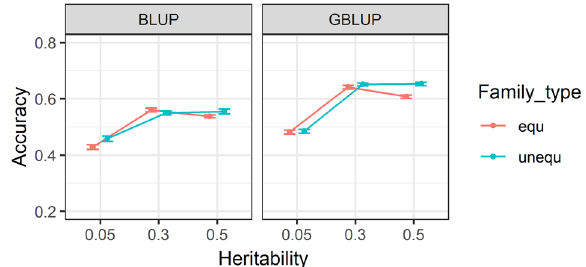
Figure 3. Accuracy of (genomic) estimated breeding values (G)EBV within three heritabilities. The accuracies are provided for equal and unequal family contributions. Accuracies in BLUP were averaged over five generations and ten replicates, while for GBLUP are estimated by averaging correlations over five generations, ten replicates, three marker densities and four genotypic error rates. Standard errors of accuracies are shown as error